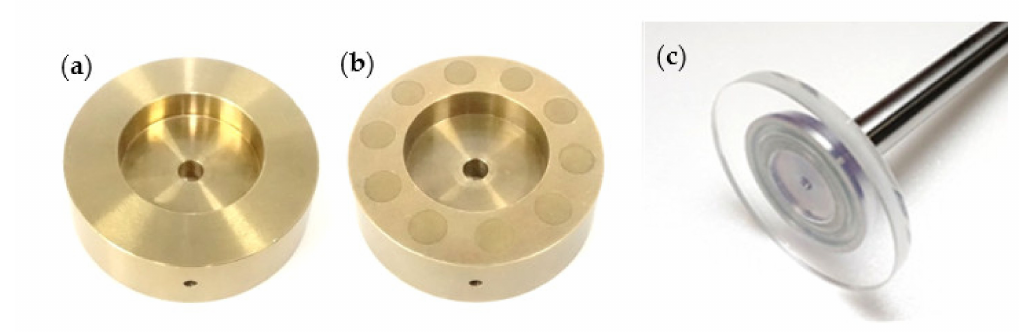
Figure 2. Photos of the specimens: ( a ) plane (dimple-free) specimen, ( b ) dimpled specimen, and ( c ) glass plate.